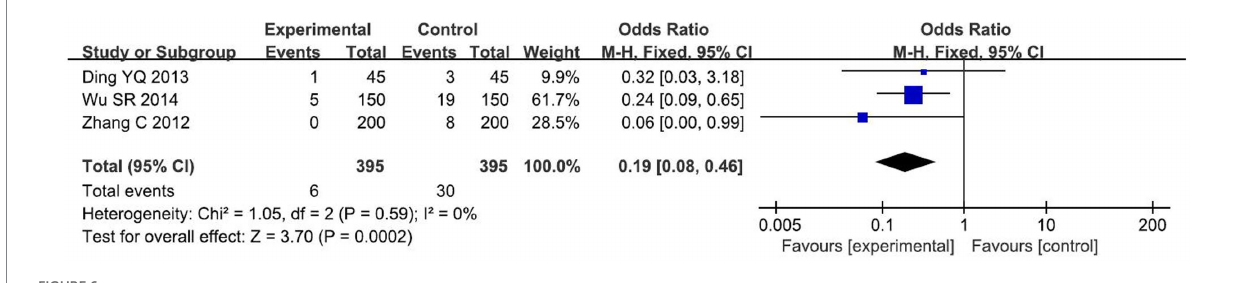
FIGURE 6 Comparison of incisional bleeding >50 mL between the two